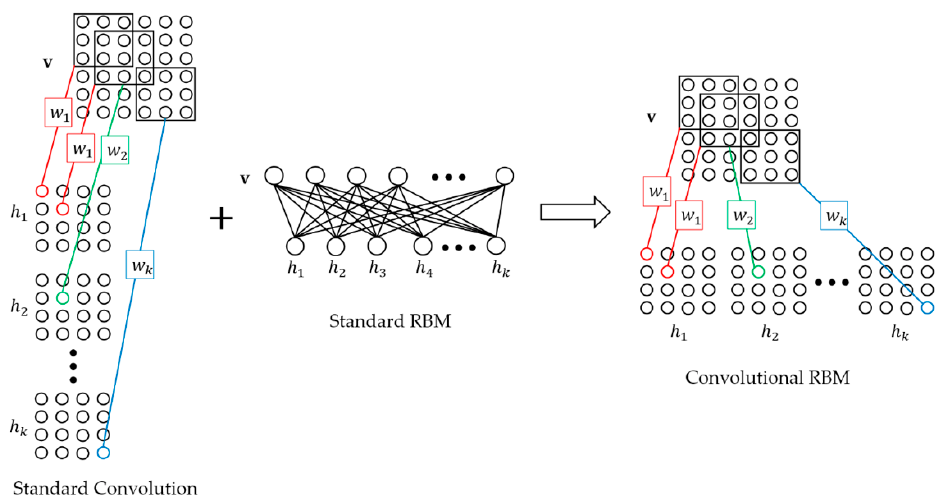
Figure 1. Convolutional Restricted Boltzmann Machine (CRBM).